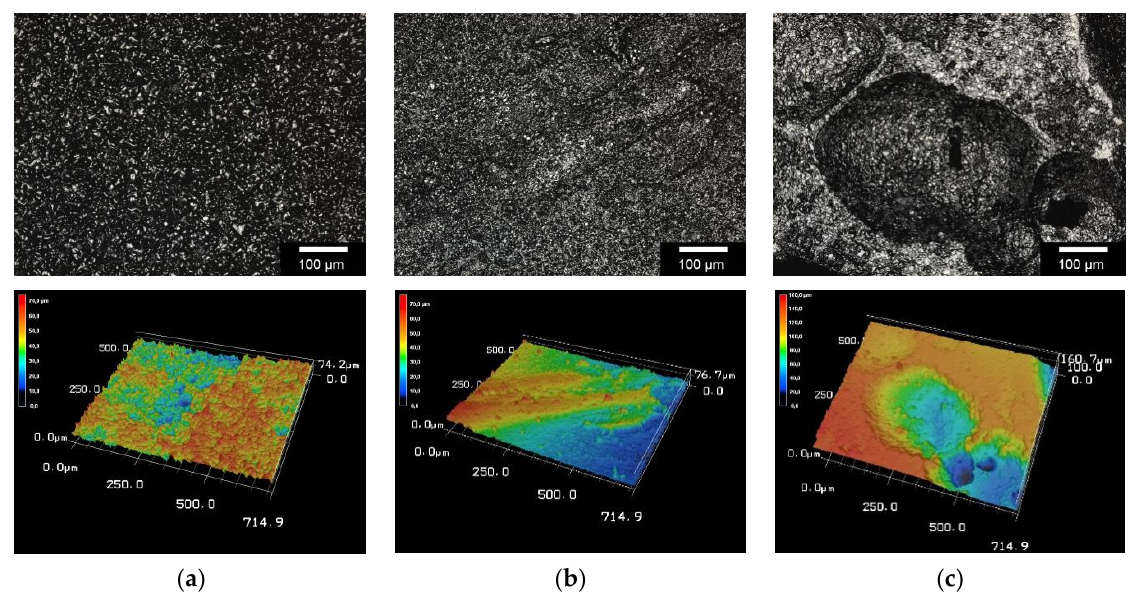
Figure 9. 3D Laser scanning image (top) and 3D reconstruction (bottom) of: ( a ) Curasan control; ( b ) Hybrid Foam, outer ceramic ring; ( c ) Hybrid Foam, inner foam. Images were taken with the KEYENCE VK-X210 3D Laser scanning microscope, 400× magnification.